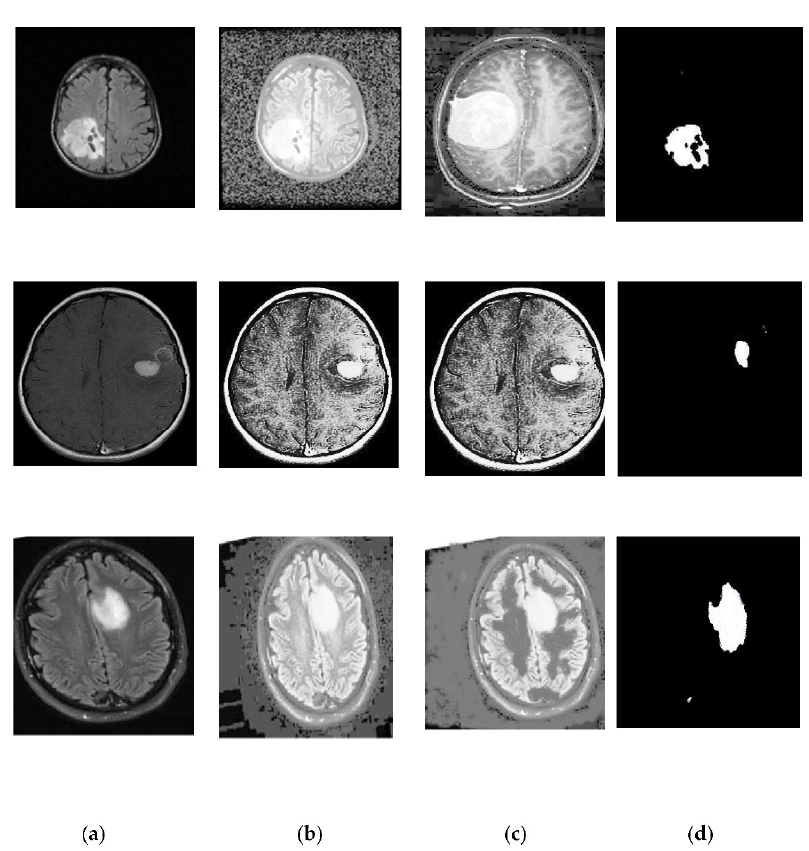
Figure 4. Segmented results of MRI images using hybrid structure of modified K-means and HHO. ( a ) Input image, ( b ) preprocessed image, ( c ) adaptive diffusion filter, ( d ) segment output after applying hybrid modified K-means and HHO.